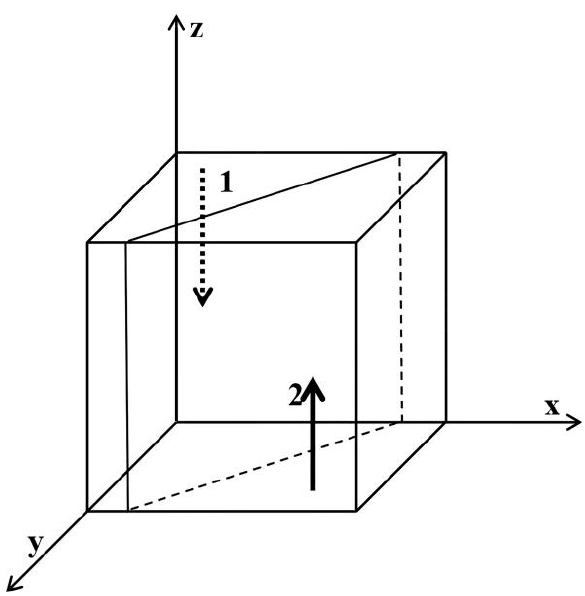
z z . Region 1 is . Region 1 is